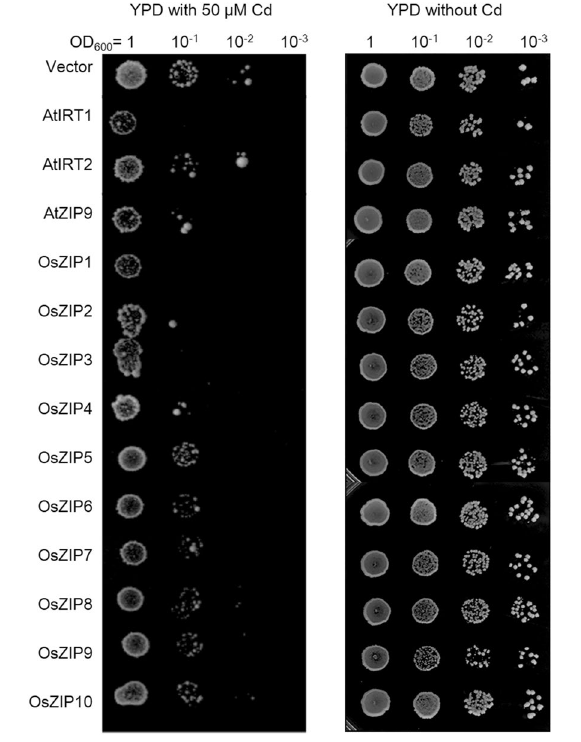
Fig. 3 Drop assay for Cd sensitivity of yeast cells ( S. cerevisiae AH109) expressing representative ZIPs tested in this study. The transformed cells expression ZIPs were subjected to a serial dilution (0–10 − 4 ) drop assay on YPD plates. 300 μg/mL G418 was added to maintain the vectors. Plates containing 50 μM CdCl 2 were incubated at 28 °C for 5 days and growth state was subsequently observed. This experiment was performed three